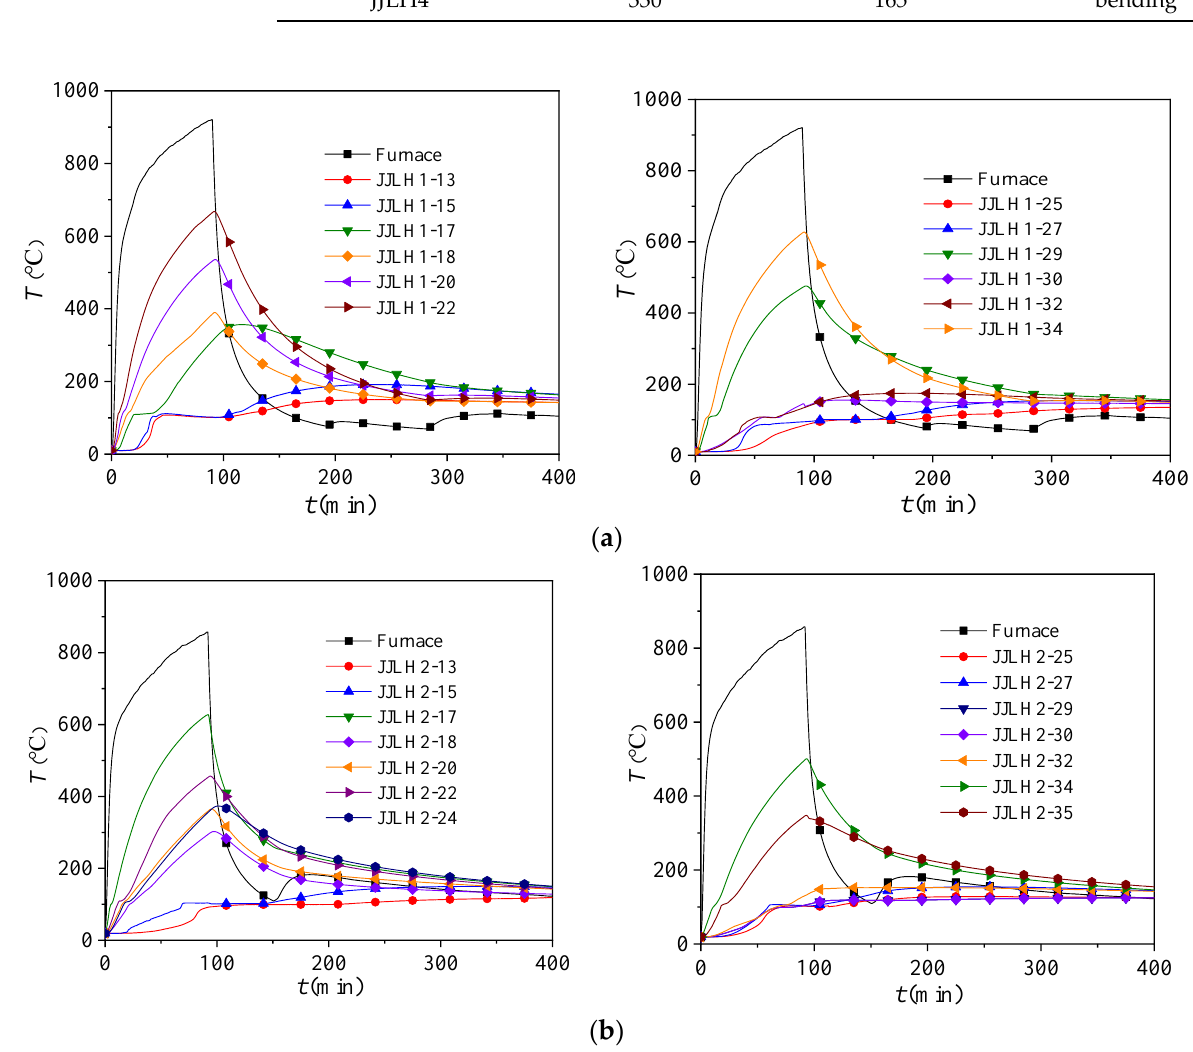
Figure 8. Measured temperature curves in the cross-section of beams: ( a ) JJLH1 and ( b ) JJLH2.